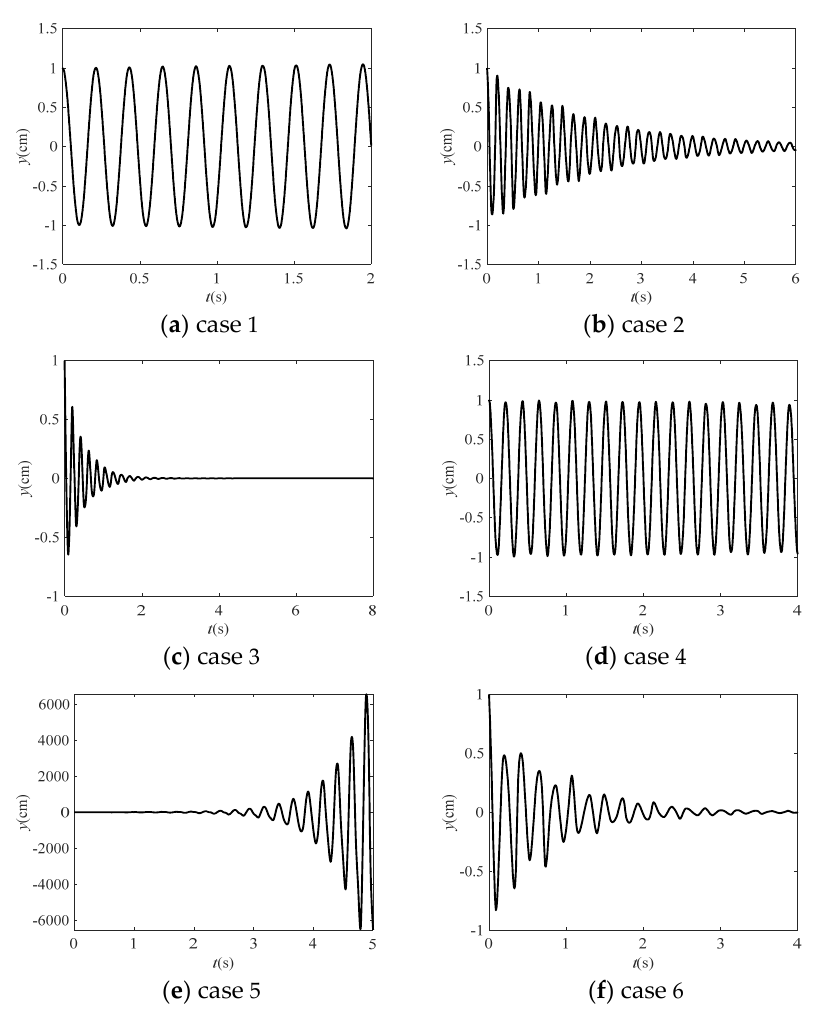
Figure 6. Time-history displacement (free vibration) in six cases.